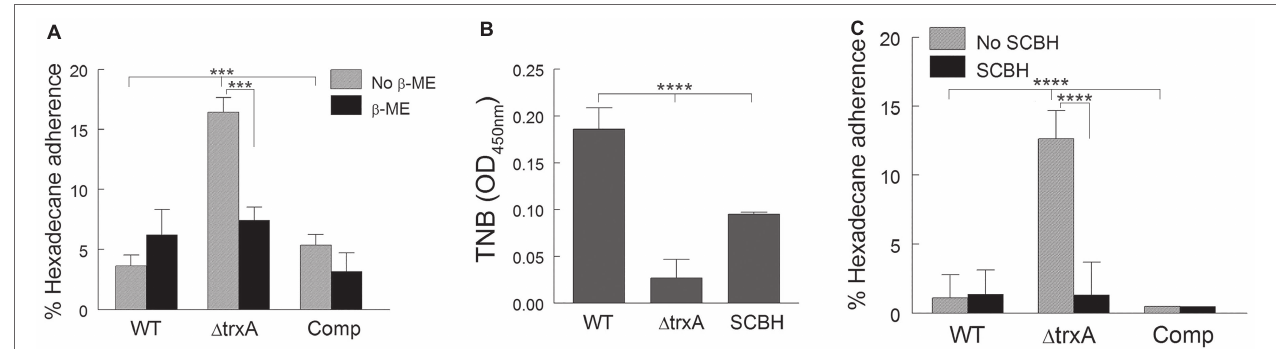
FIGURE 2 | Modulation of cell surface hydrophobicity is dependent on disulfide bond reduction. (A) Adherence of wild type (WT), Δ trxA and complement (Comp) strains to n-hexadecane with and without β -mercaptoethanol ( β -ME) treatment. (B) Reduction of disulfide bonds by SCBH as measured through reduction of DTNB to TNB. (C) Adherence to n-hexadecane with and without sodium cyanoborohydride (SCBH) treatment. Statistical differences were determined by one-way (B) or two-way (A,C) ANOVA with Holm-Sidak correction for multiple comparisons (**** p < 0.0001, *** p < 0.001).